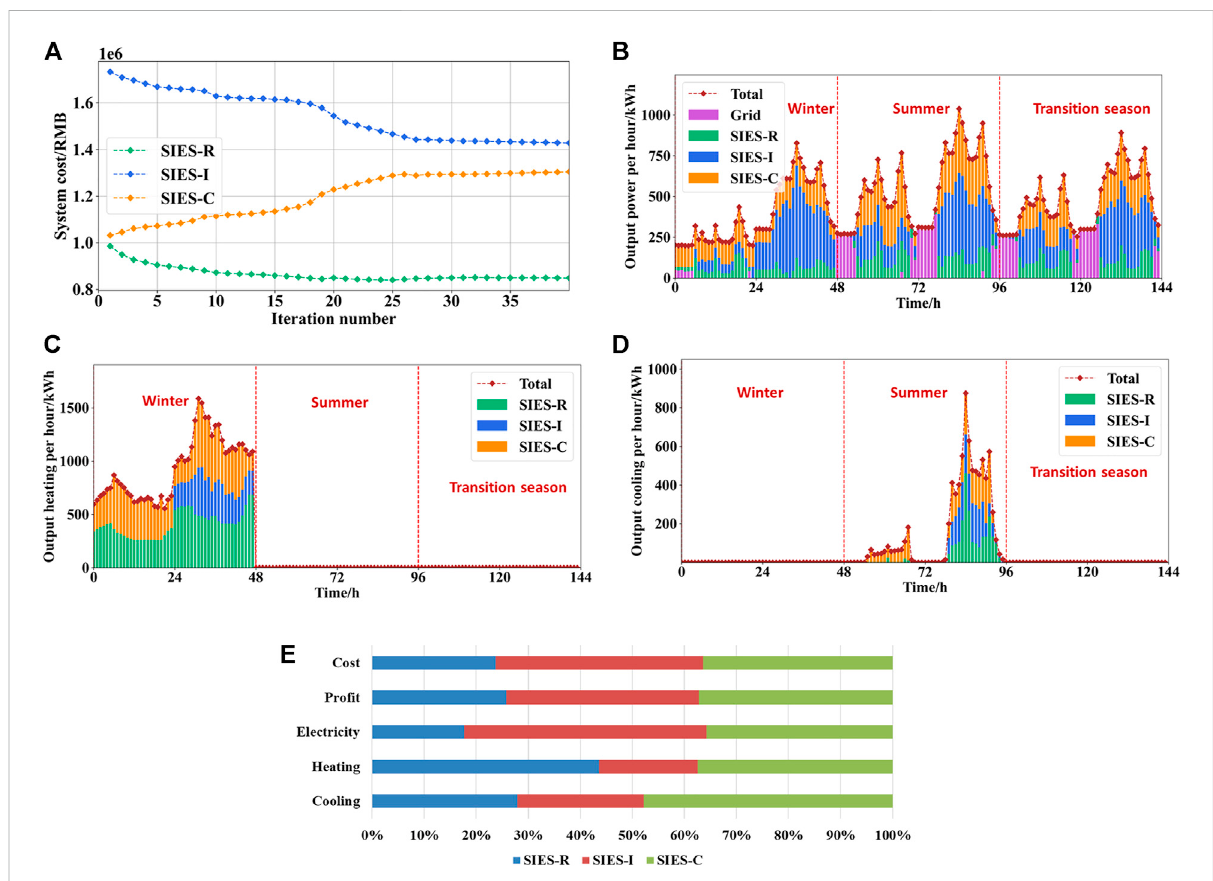
FIGURE 8 Theresultsofdistributedoptimizationfortypicaldays.Figure (A) showsthesystemcostintheiterationprogress.Theoutputelectricity,heating, and cooling are shown in (B – D) , respectively. Figure (E) shows the output and pro fi t allocation for different